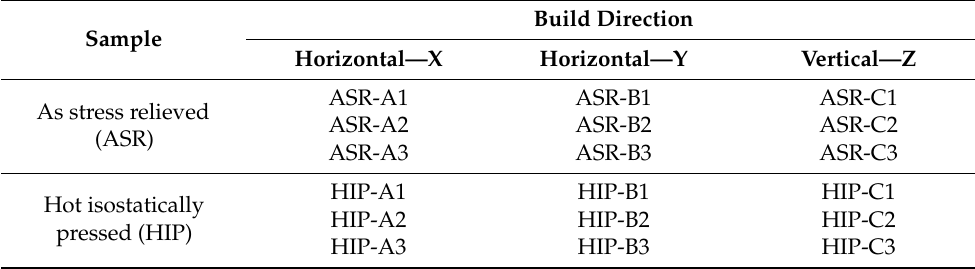
Table 1. Sample identification employed in this